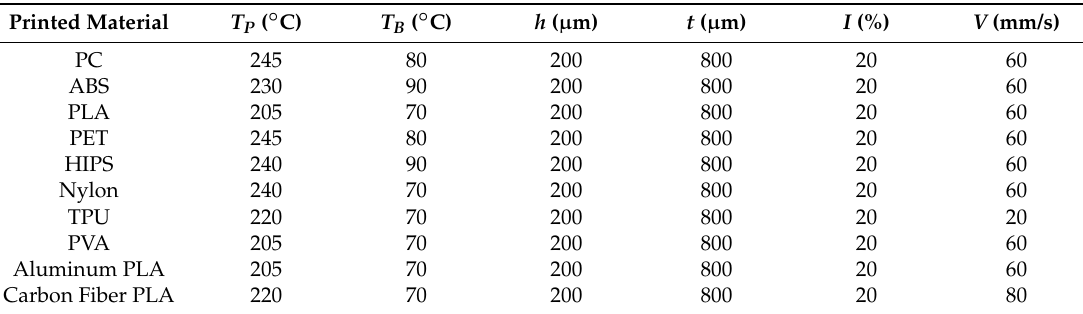
Table 3. Test part processing parameters.